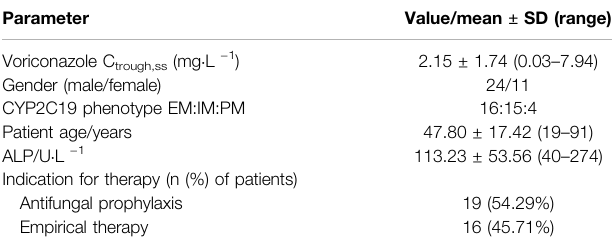
TABLE 2 | demographic parameters for 35 patients and voriconazole plasma concentration